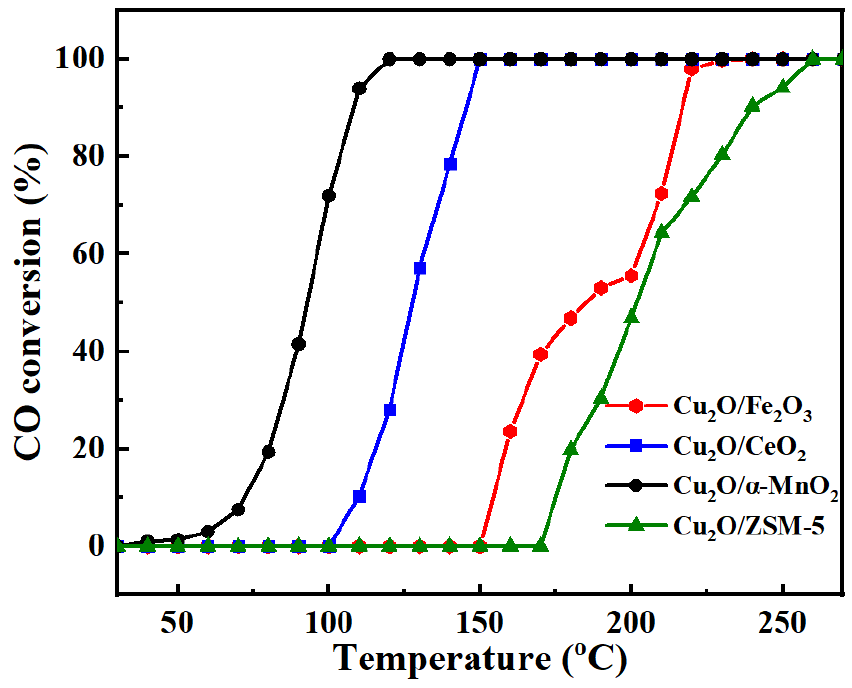
Figure 1. The curves of CO conversion versus reaction temperature over the as-prepared Cu 2 O/S (S = ZSM-5, CeO 2 , α -MnO 2 , and Fe 2 O 3 ) catalysts; reaction conditions: CO/O 2 /N 2 = 1/20/79, GHSV = 12,000 mL g − 1 h − 1 , 1 atm.